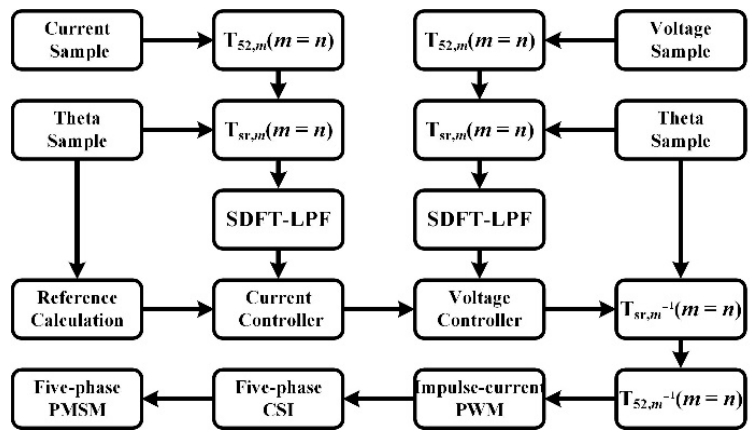
Figure 4. The specific control flowchart of the n th harmonic current.